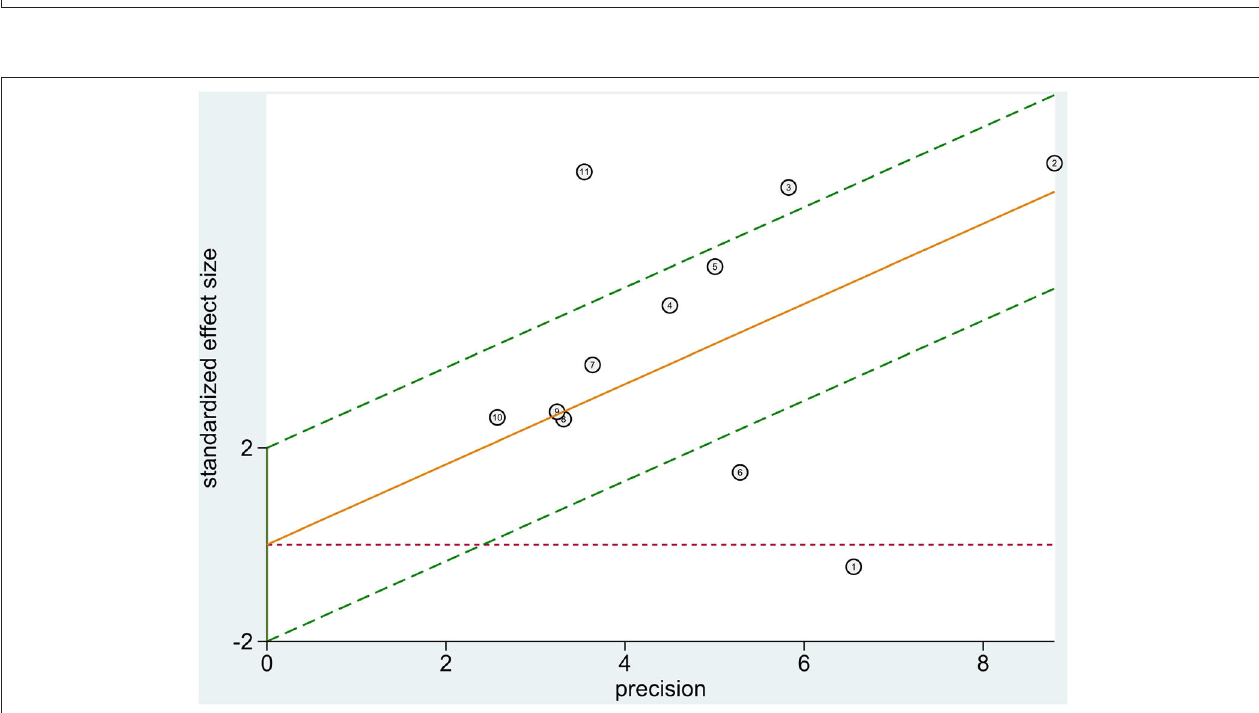
FIGURE 5 | Heterogeneity analysis. Heterogeneity was evaluated by Galbraith radial plot.